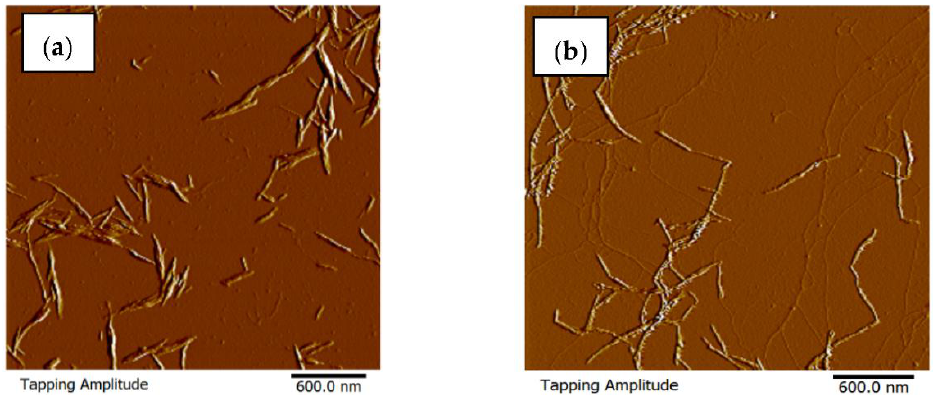
Figure 2. Images of NCC ( a ) and NFC ( b ) observed under AFM. Table 3. Width and length of nanocellulose. Type of Nanocellulose Width